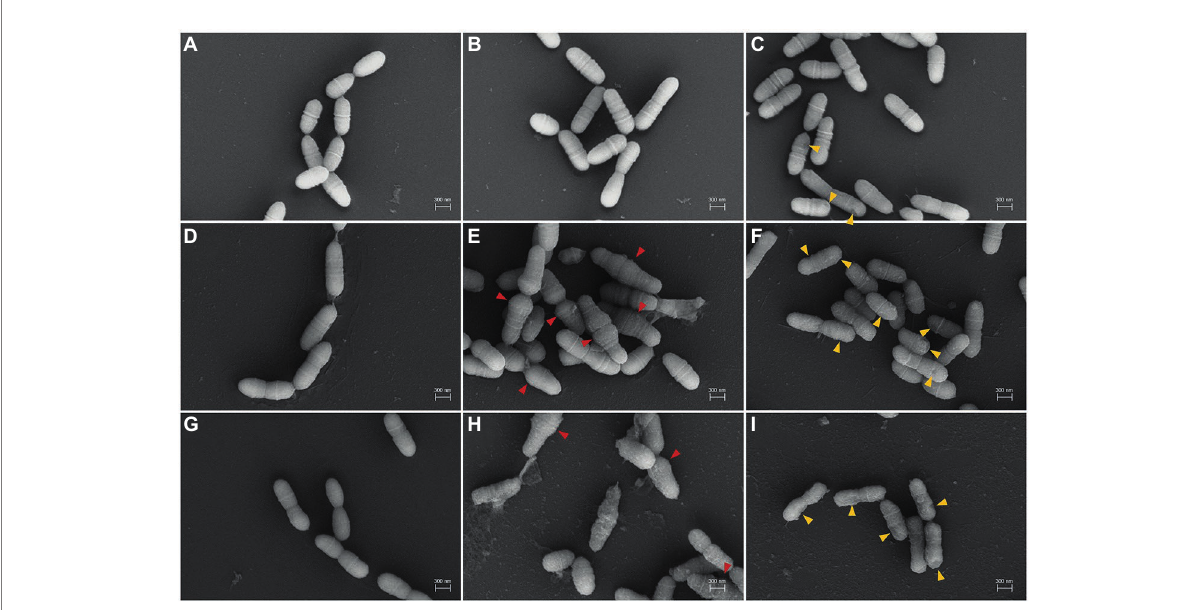
FIGURE 3 Scanning electron microscopy (SEM) micrographs of S. mutans treated with DM. (A–C) , 1 h treatment; (D–F) , 6 h treatment; (G–I) , 24 h treatment. (A,D,G) , untreated; (B,E,H) , treated with 4 μ g/ml; (C,F,I) , treated with 40 μ g/ml. Red and orange arrows indicate aberrant morphology and abnormal extracellular coating by DM treatment,